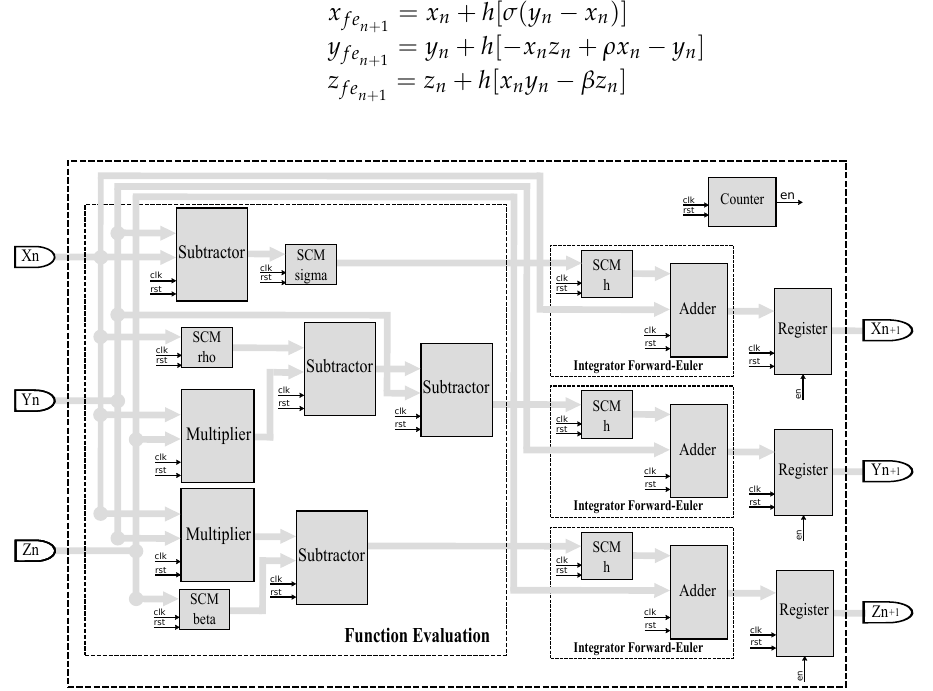
Figure 5. Block diagram of Equation (4) for field-programmable gate array (FPGA) implementation applying Forward Euler